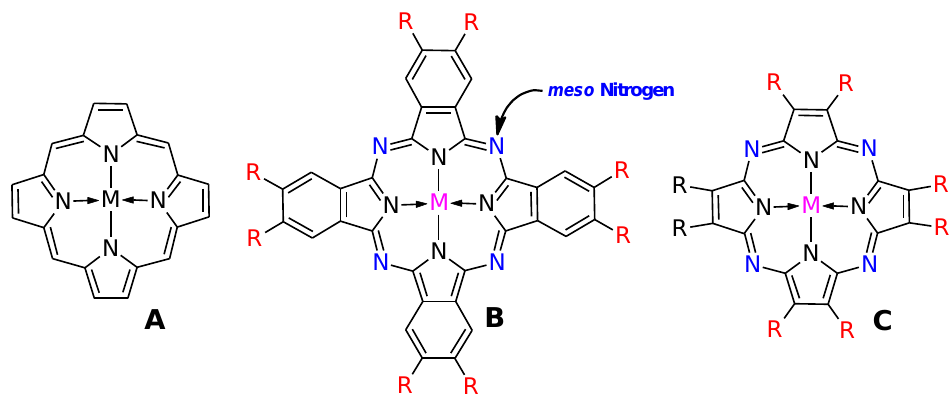
Figure 1. The chemical structure of porphyrin ( A ), phthalocyanine ( B ) and porphyrazine ( C ) rings. “R” stands for peripheral substituents and “M” indicates metal cation inside core.